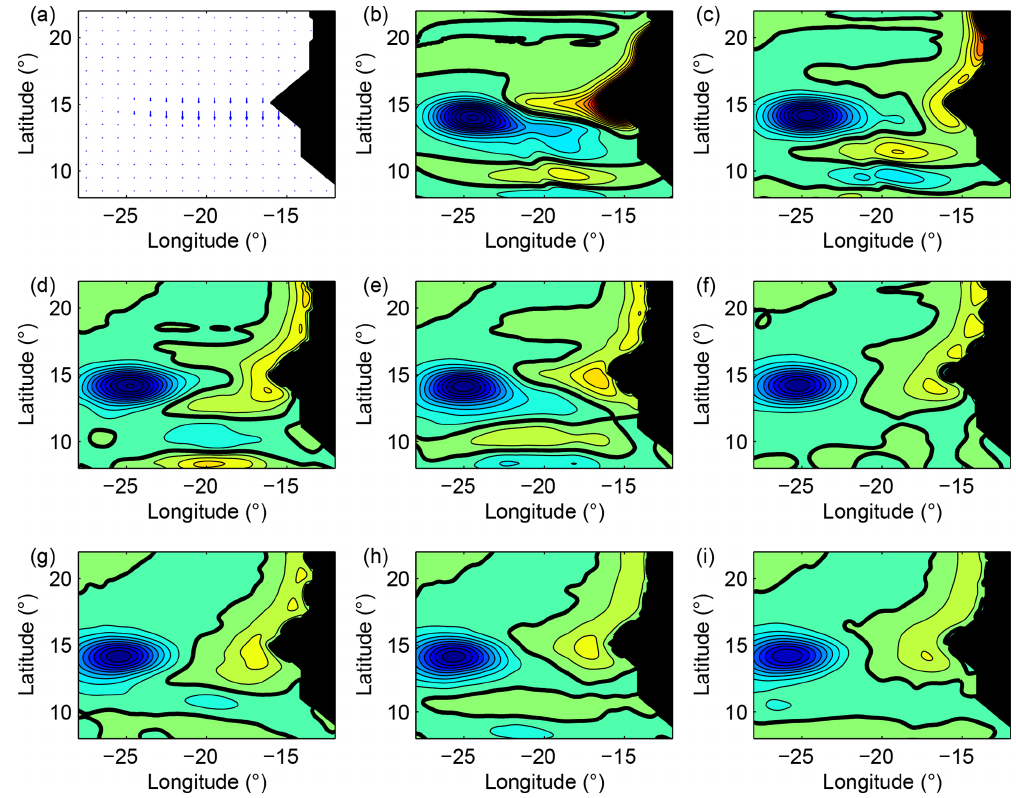
Figure 7. The wind anomaly now acts over a long (1000km) and narrow (200km) domain south of the cape for 5d (a) . The solution after the close of the wind burst is shown. A wave is generated, but the anomaly remains moderate near the coast. The 0m isoline is indicated in bold; the isoline interval is 0.1m (blue: